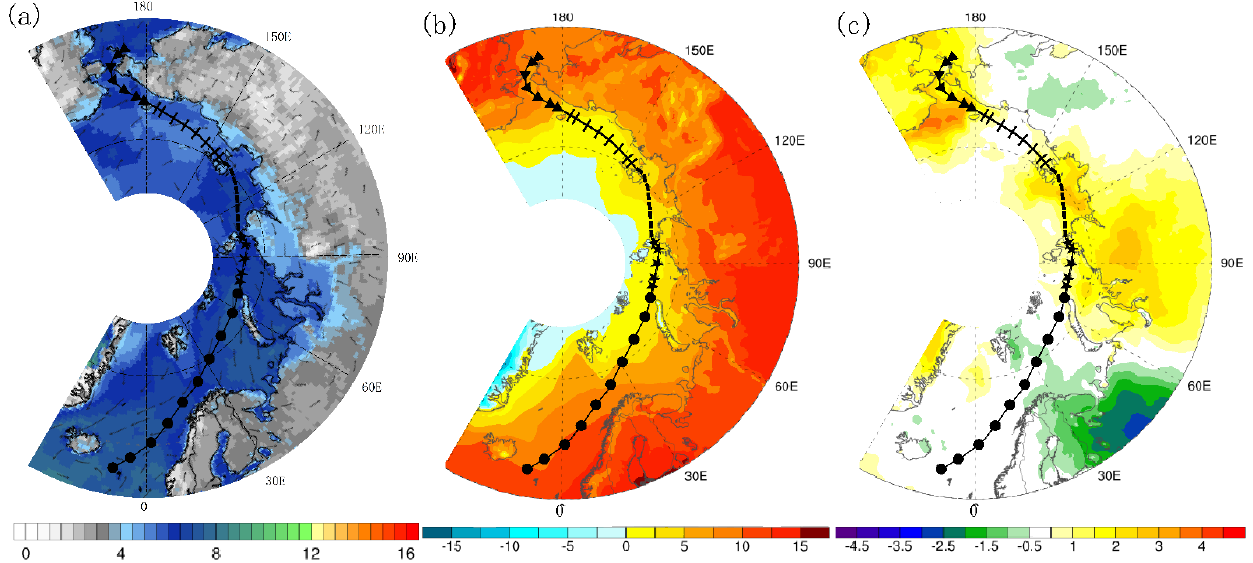
Figure 24. The average wind field ( a ), average temperature ( b ) and temperature anomalies ( c ) of the NEP in the Arctic summer in 2019.